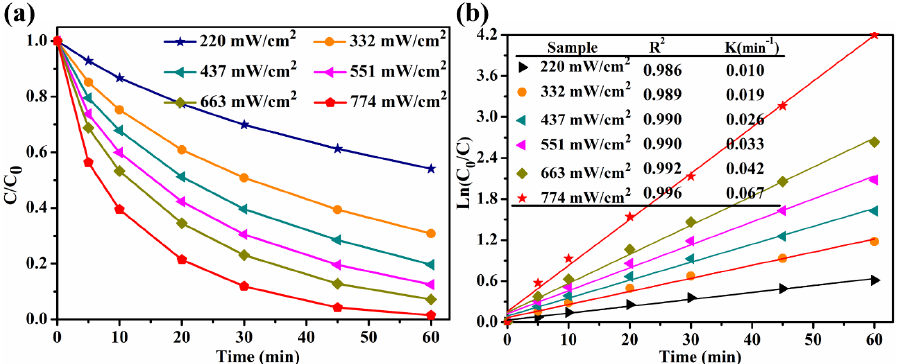
Figure 5. ( a ) Effect of varying UV-LED light intensities on ATL degradation, ( b ) Pseudo- first-order model of ATL degradation. initial ATL concentration of 18.77 µM and mixed phase concentration of 2.0 g/L; pH: 7.6; temperature: 20 °C.